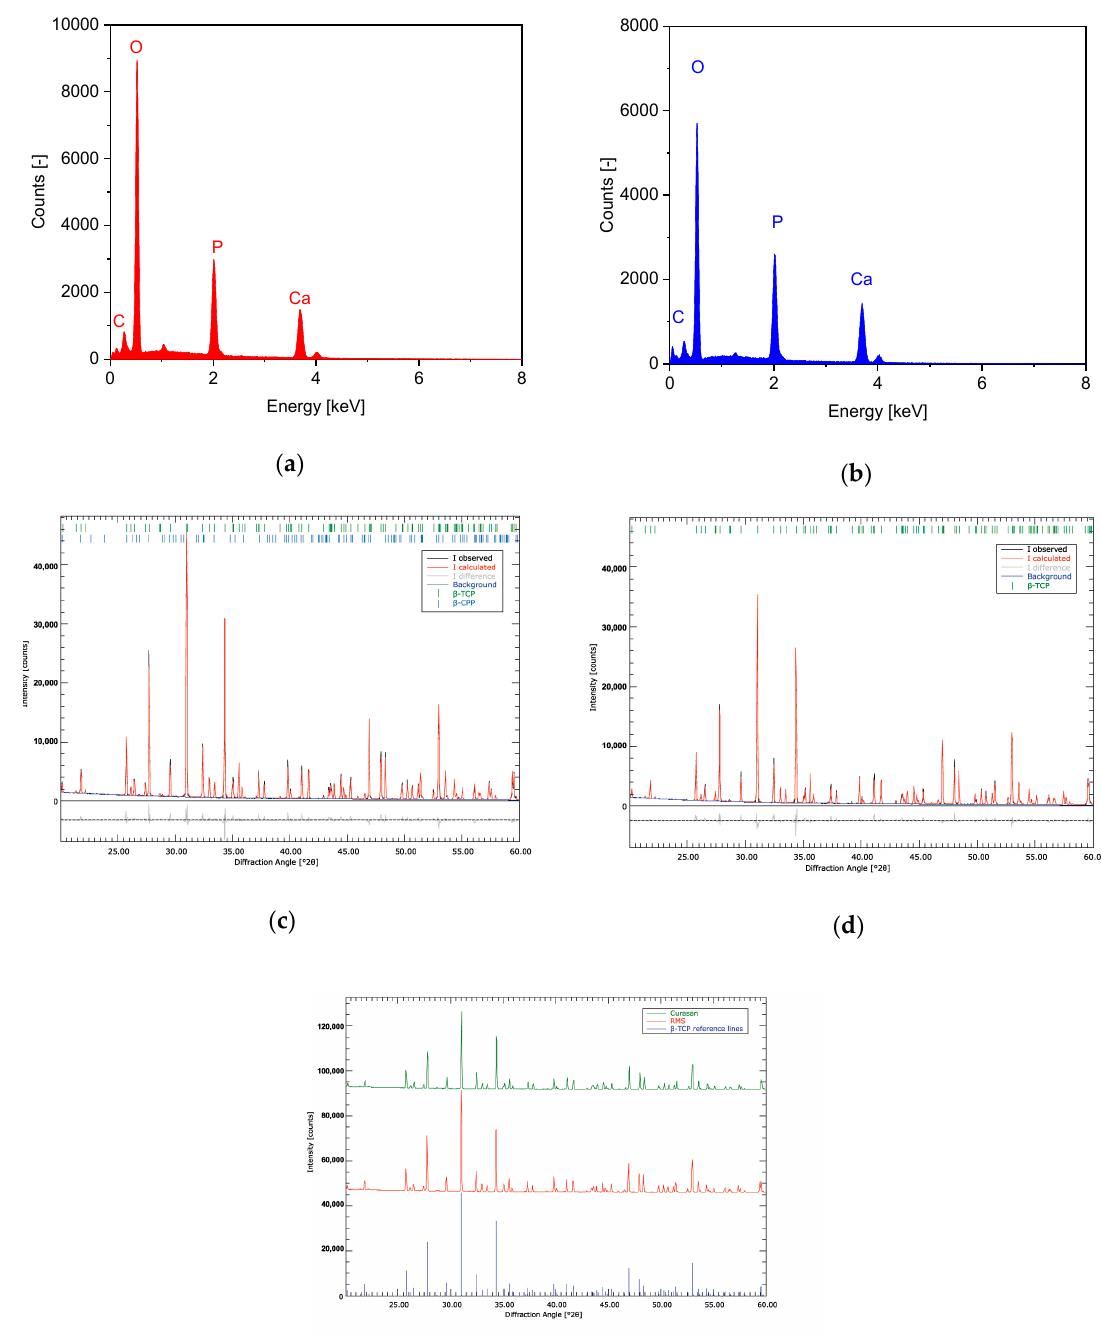
Figure 2. Dispersive X-ray spectroscopy (EDX) spectra of ( a ): RMS ceramics; ( b ): Curasan Ceramics; XRD pattern of ( c ): RMS ceramics; ( d ): Curasan ceramics; ( e ): XRD pattern RMS, Curasan with reference lines for β -TCP; EDX measurements carried out at Philips XL 30 FEG ESEM with EDX unit, 12 kV acceleration voltage and 300 s lifetime counting period; XRD measurements with Bruker D8 Advance, (measurement conditions: 40 kV/40 mA, 1°2 theta/min, step size 0.02°2 theta).